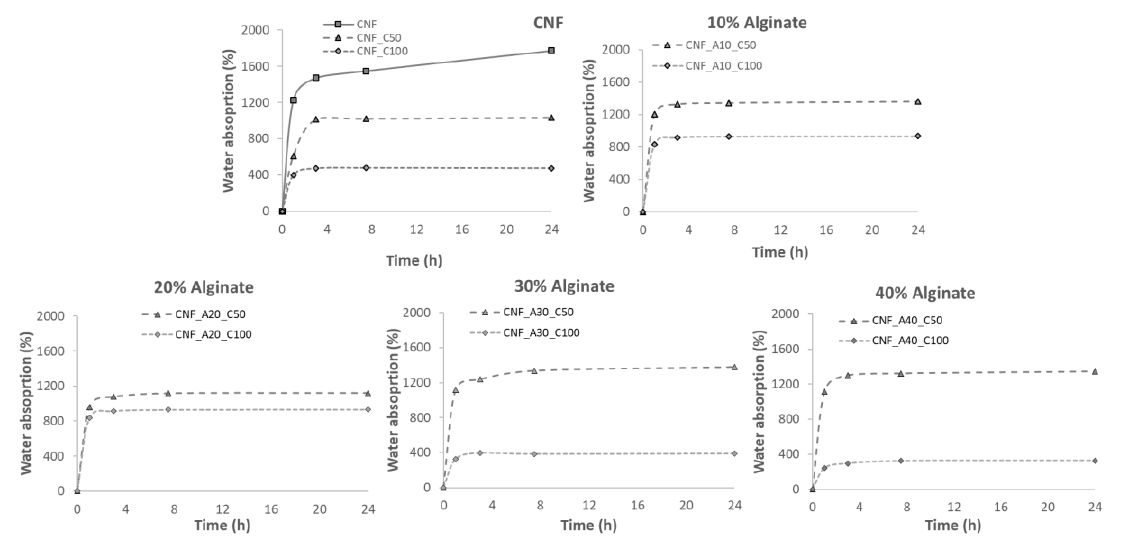
Figure 5. Water absorption curves for the different aerogels.